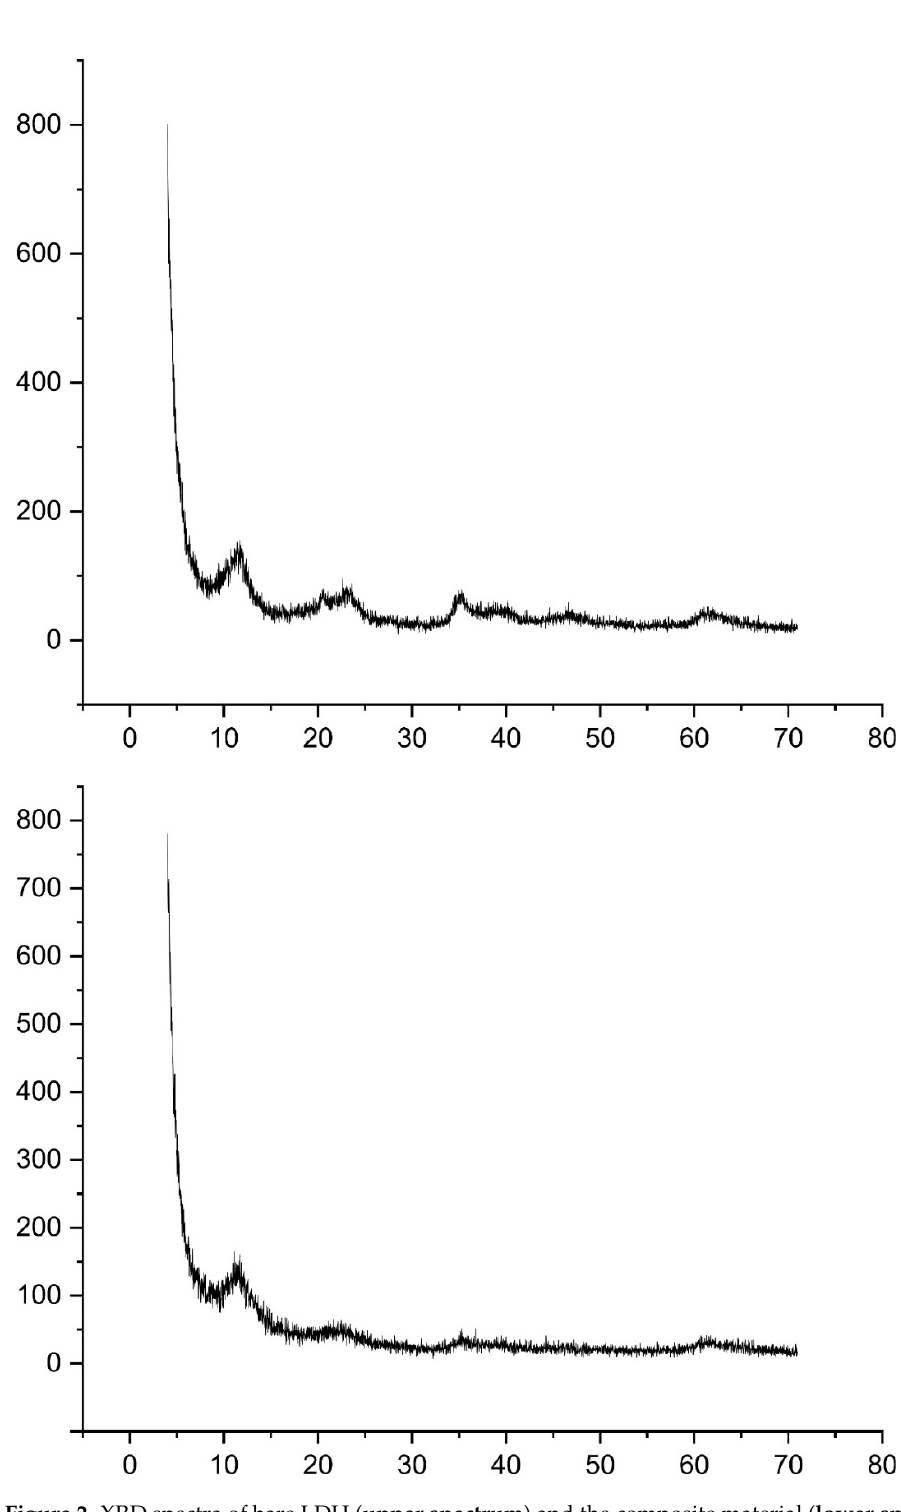
Figure 2. XRD spectra of bare LDH ( upper spectrum ) and the composite material ( lower spectrum ).